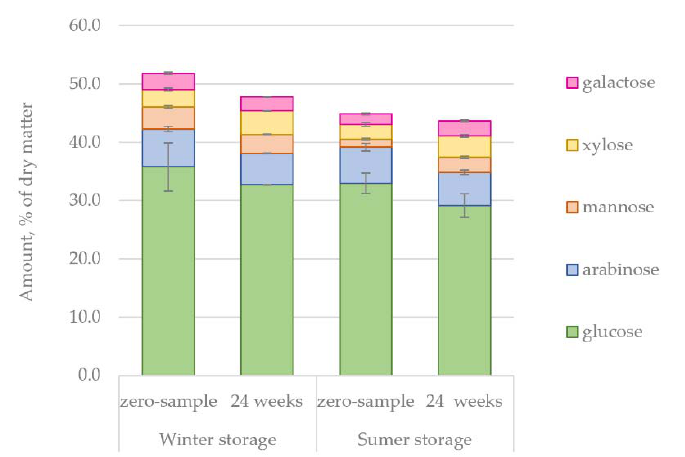
Figure 16. The high-performance anion-exchange chromatography (HPAEC) results of the changes Figure 16. The high ‐ performance anion ‐ exchange chromatography (HPAEC) results of the changes in monosaccharide content during winter and summer storage. in monosaccharide content during winter and summer